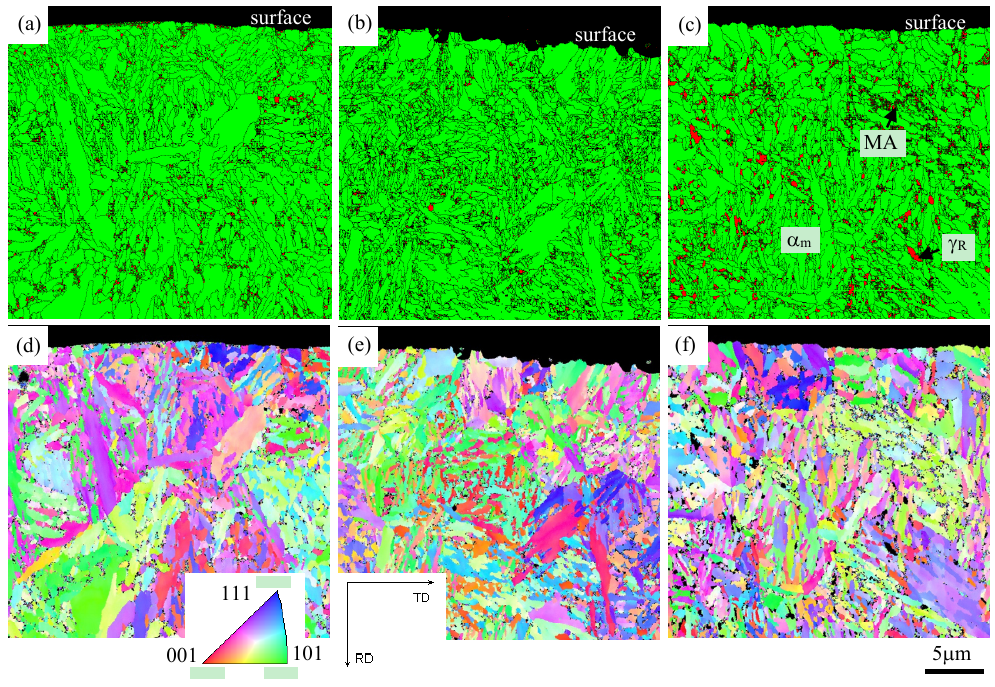
Figure 2. ( a – c ) Phase maps and ( d – f ) orientation maps of the α‐ bcc phase of a cross ‐ sectional side view of the surface ‐ hardened layer of transformation ‐ induced TRIP ‐ aided martensitic (TM) steel subjected to vacuum ‐ carburization under various carbon potentials of ( a , d ) C P = 0.70 mass %, ( b , e ) C P = 0.75 mass % and ( c , f ) C P = 0.80 mass %. In ( a – c ), yellowish green, gray and red regions represent the α ’ ‐ martensite ( α m ) matrix, MA ‐ like (MA) phase and retained austenite ( γ R ) islands, respectively.